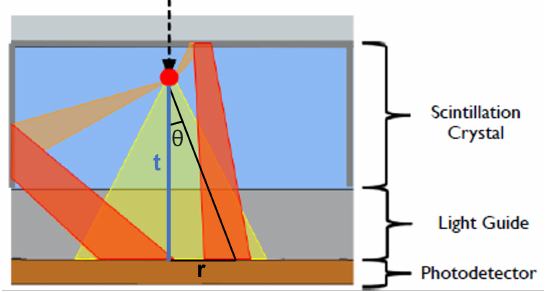
Figure 5. Scheme to illustrate the parameters in Scrimger and Baker